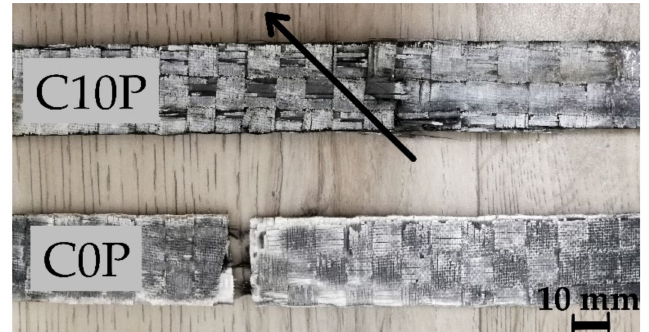
Figure 8. Characteristic fiber break with sample C10P after tensile strength and break of sample C0P with very brittle